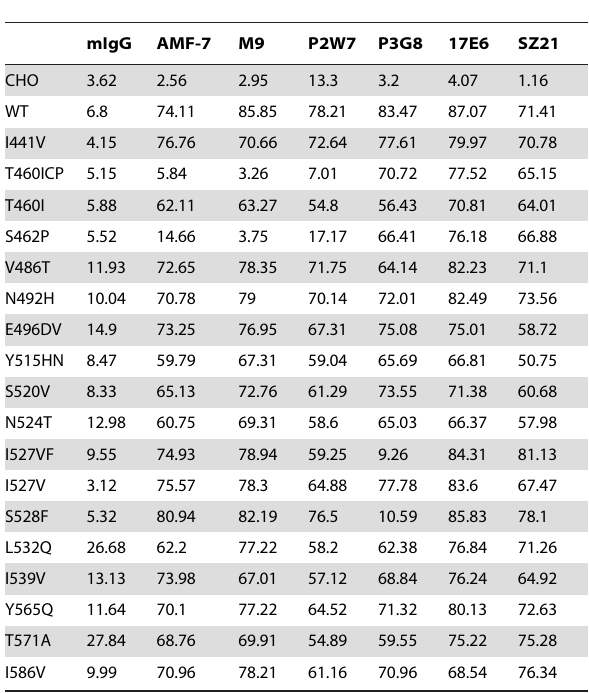
Table 3. MAb binding to cells expressing human-to-mouse a V